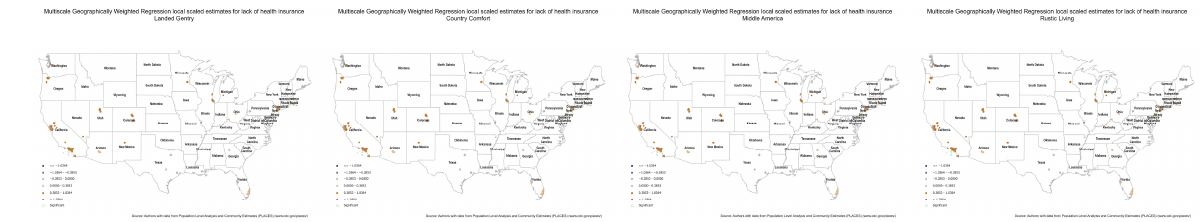
Figure 3. Multiscale Geographically Weighted Regression local scaled estimates for lack of healthcare by social group. Brown dots indicate a highly positive impact of the lack of health insurance on mental health, while purple dots indicate a negative relationship.